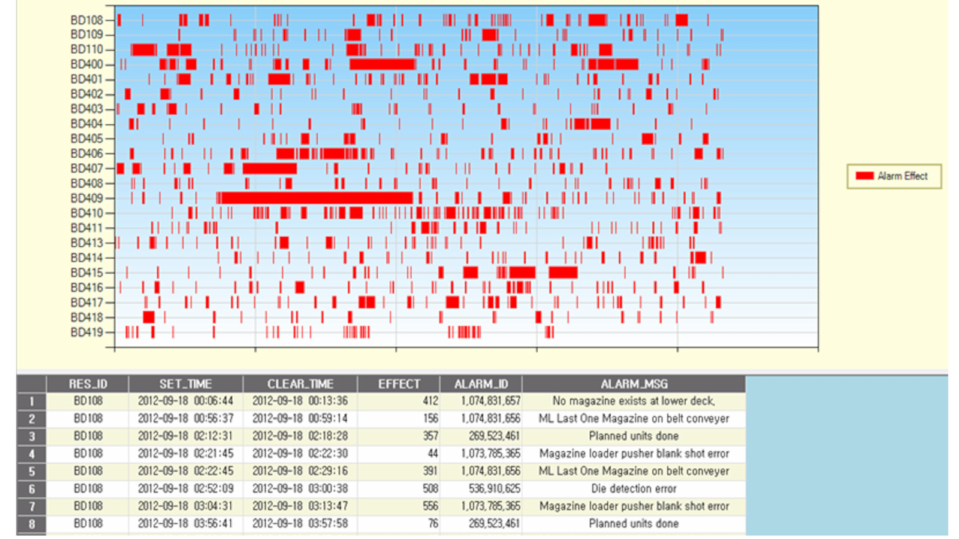
Figure 3. Loss frequency and loss duration time analysis in die attach process equipment.